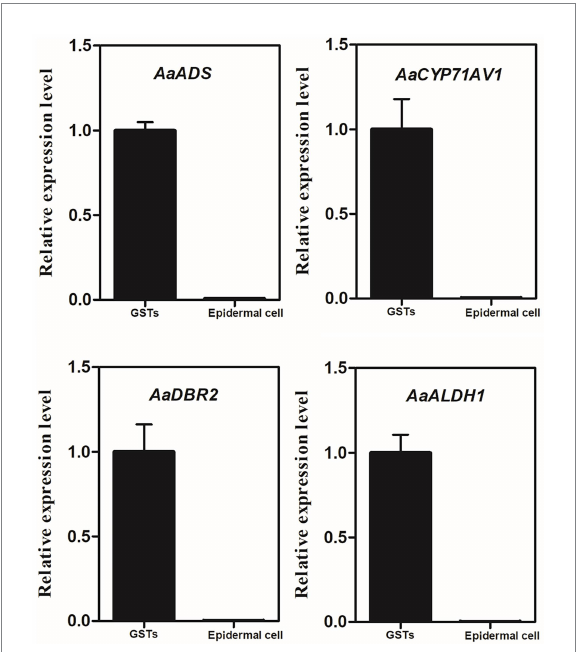
FIGURE 5 Relative expression of AaADS , AaCYP71AV1 , AaDBR2 and AaALDH1 in GSTs and epidermal cells of A. annua by quantitative real-time polymerase chain reaction. β -actin was used as an internal control. Error bars represent the standard deviation ( n = 3